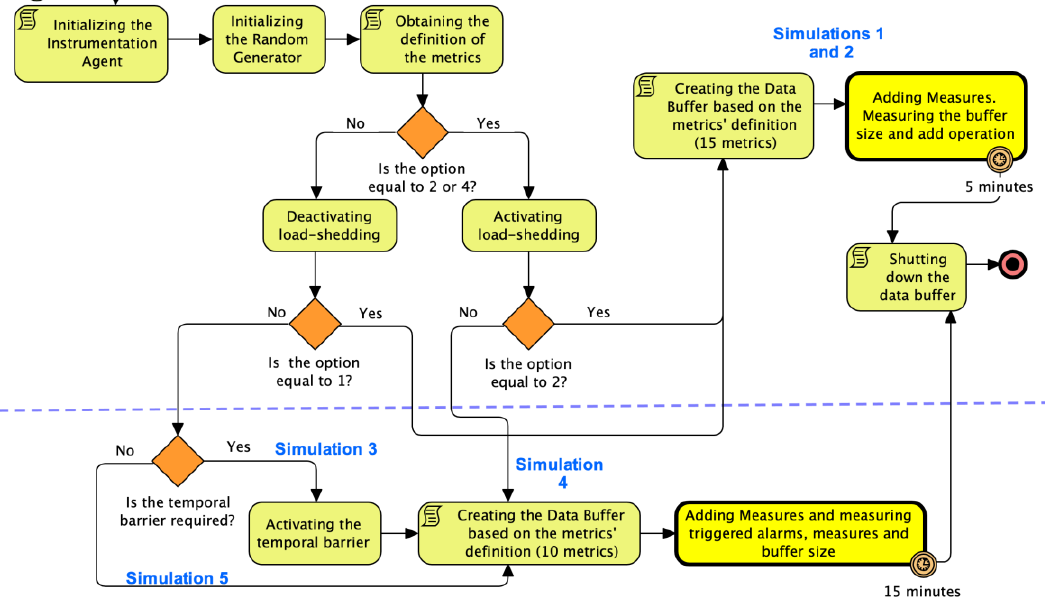
Figure 4. A BPMN diagram describing the discrete simulation